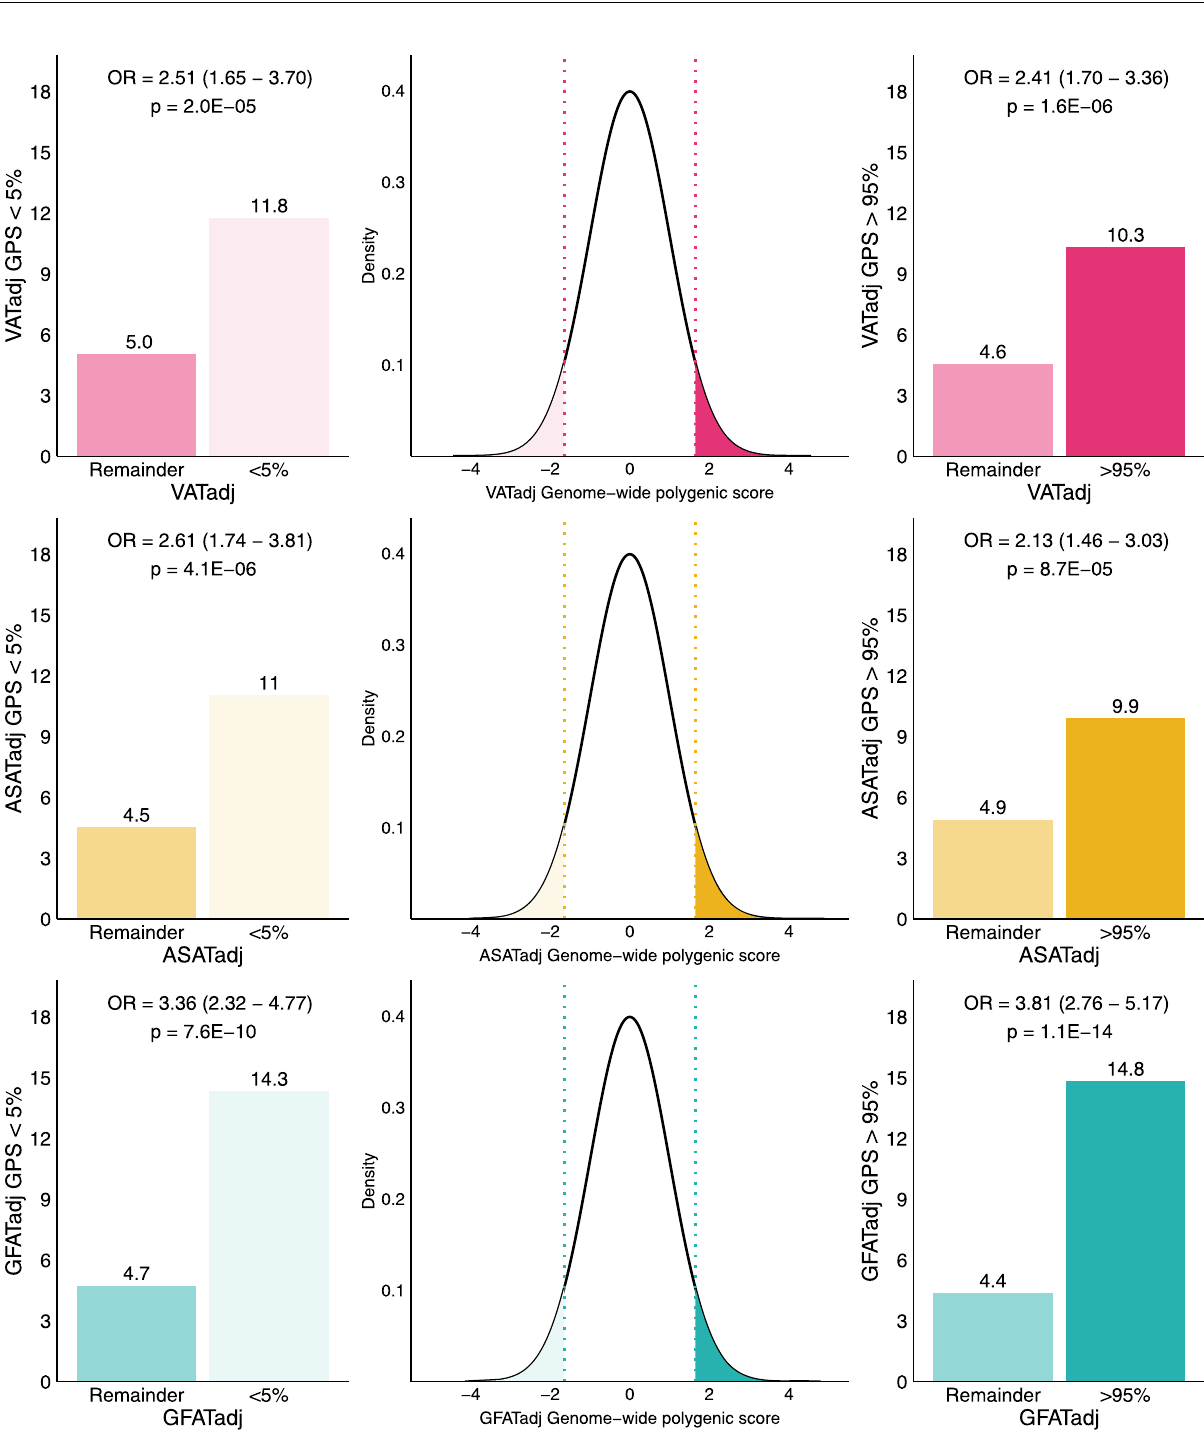
Fig. 6 Enrichment of VATadj, ASATadj, and GFATadj genome-wide polygenic scores in tails of the distribution. For each fat depot “ adj ” trait, a polygenic score was trained using LDpred2 on 70% of the studied cohort and a 10% validation cohort was used to determine the optimal set of hyperparameters. Results in this fi gure correspond to the 20% imaged and testing set ( N = 7795). Supplementary Fig. 18 shows the full distribution of each polygenic score in each tail of VATadj, ASATadj, and